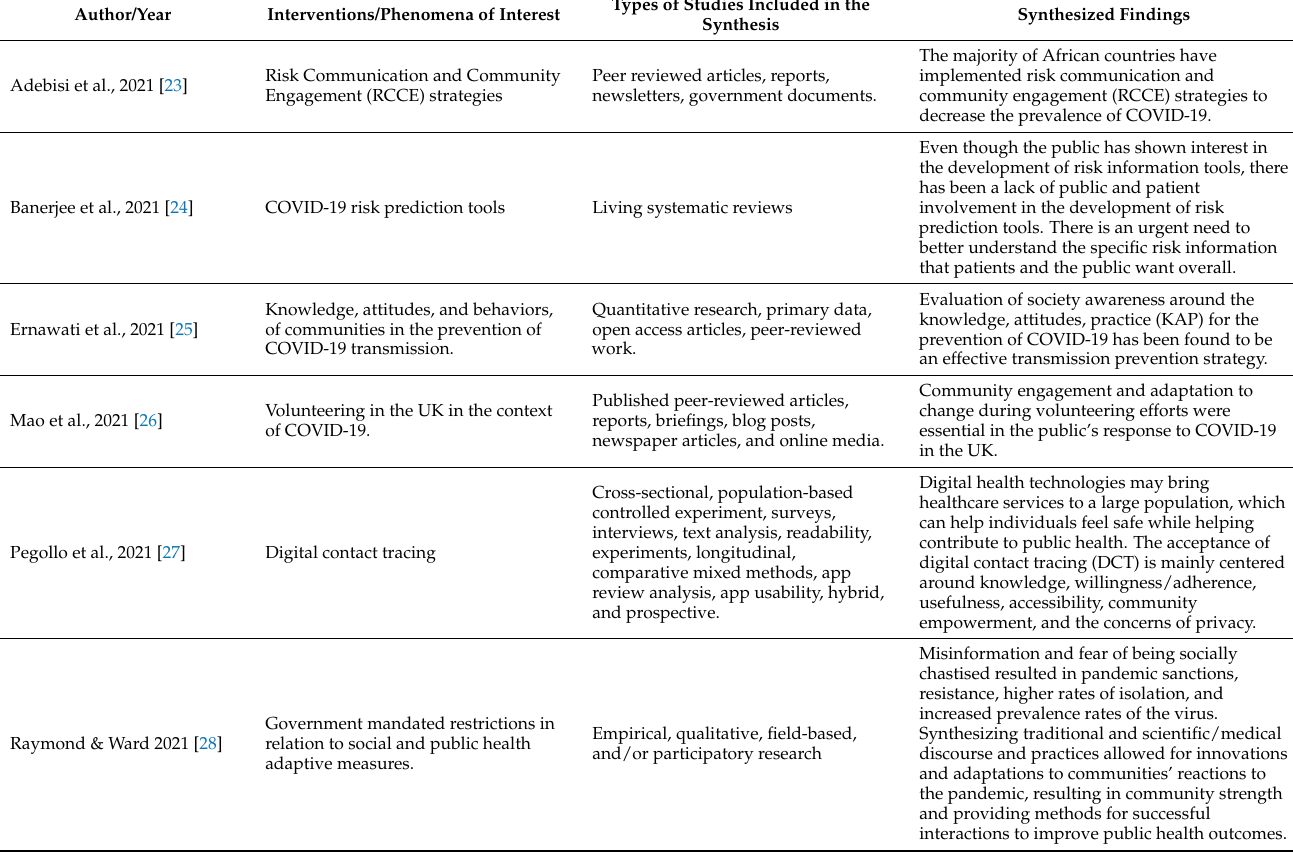
Table 4. Summary of evidence for the effect of patient and public involvement (PPI) on public health measures (PHM) and community